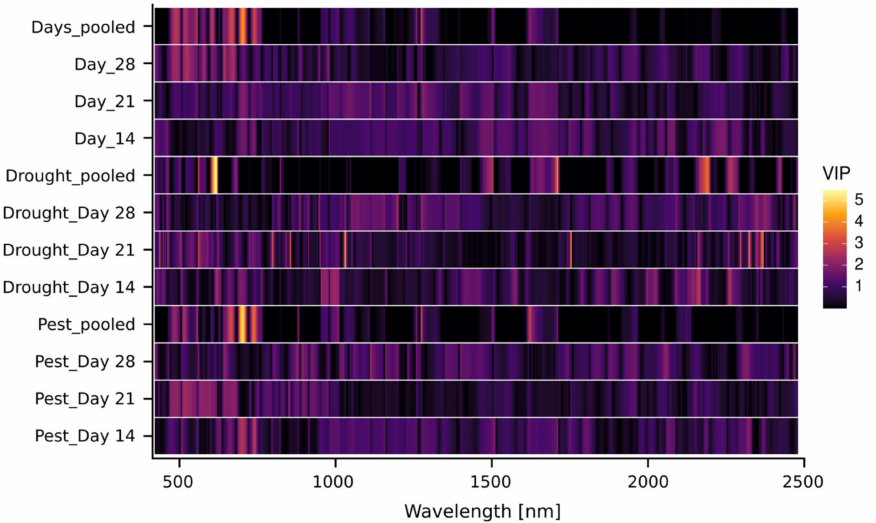
a Group: day 14/21/28 identification of all treatment groups for each imaging session (the number designates the imaging session); pest 14/21/28: identification of infested plants; drought 14/21/28: identification of plants under drought stress; b N: number of samples in the test set; c LV: number of selected latent variables; d Var: cumulative explained variance of the selected LVs; e Maximum/centroids/Mahalanobis: distance measures for sPLS-DA classification error rates; f c: SVM cost function value; g Sigma: SVM sigma value; h OA: overall accuracy of sPLS- SVM classification; i Kappa: kappa statistic of repeated cross validation; j Class: class designation by treatment group (ZP341 N/D, N/W, Y/D and Y/W; FuturiXX N/D, N/W, Y/D and Y/W) for each imaging session;